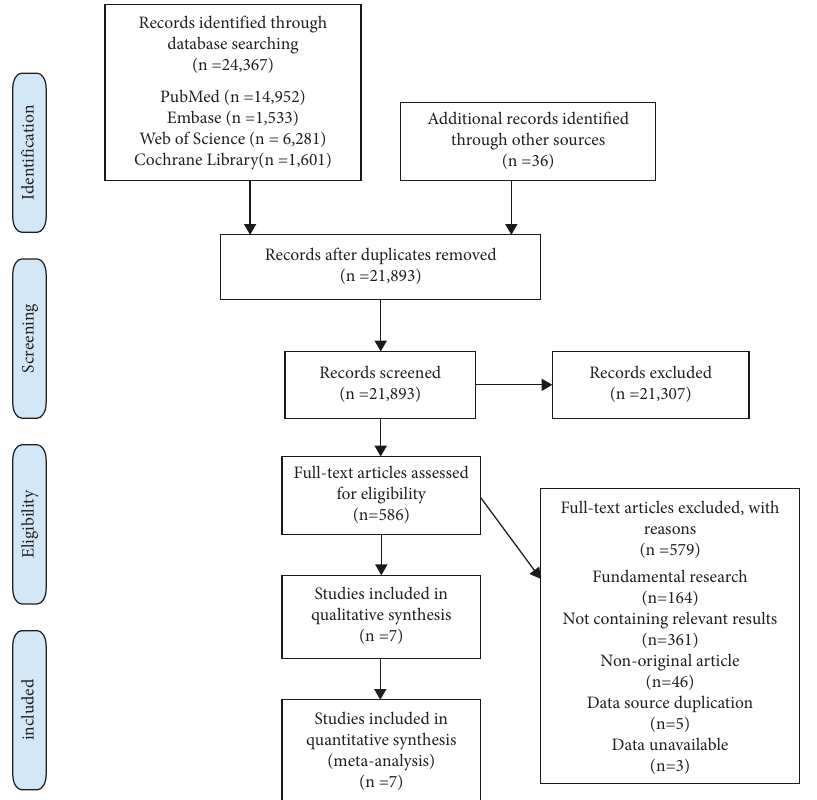
Figure 1: Flow diagram for the selection process of included